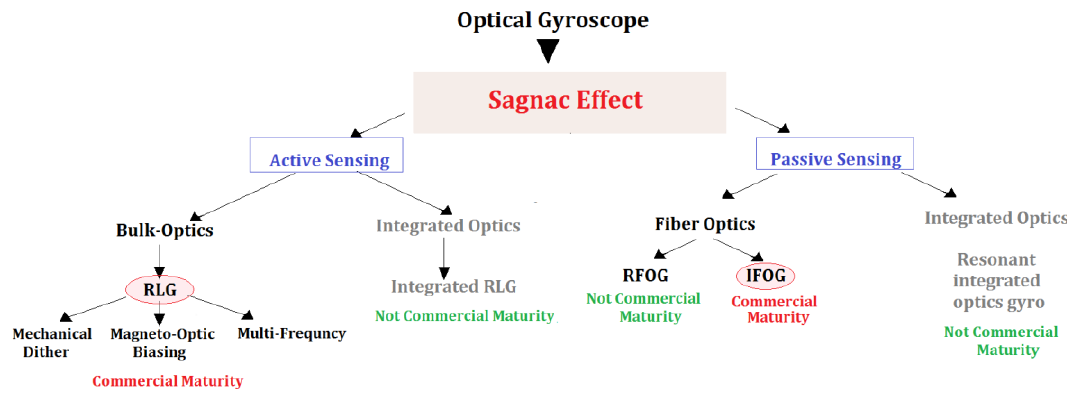
Figure 4. Classes of optical gyroscopes.